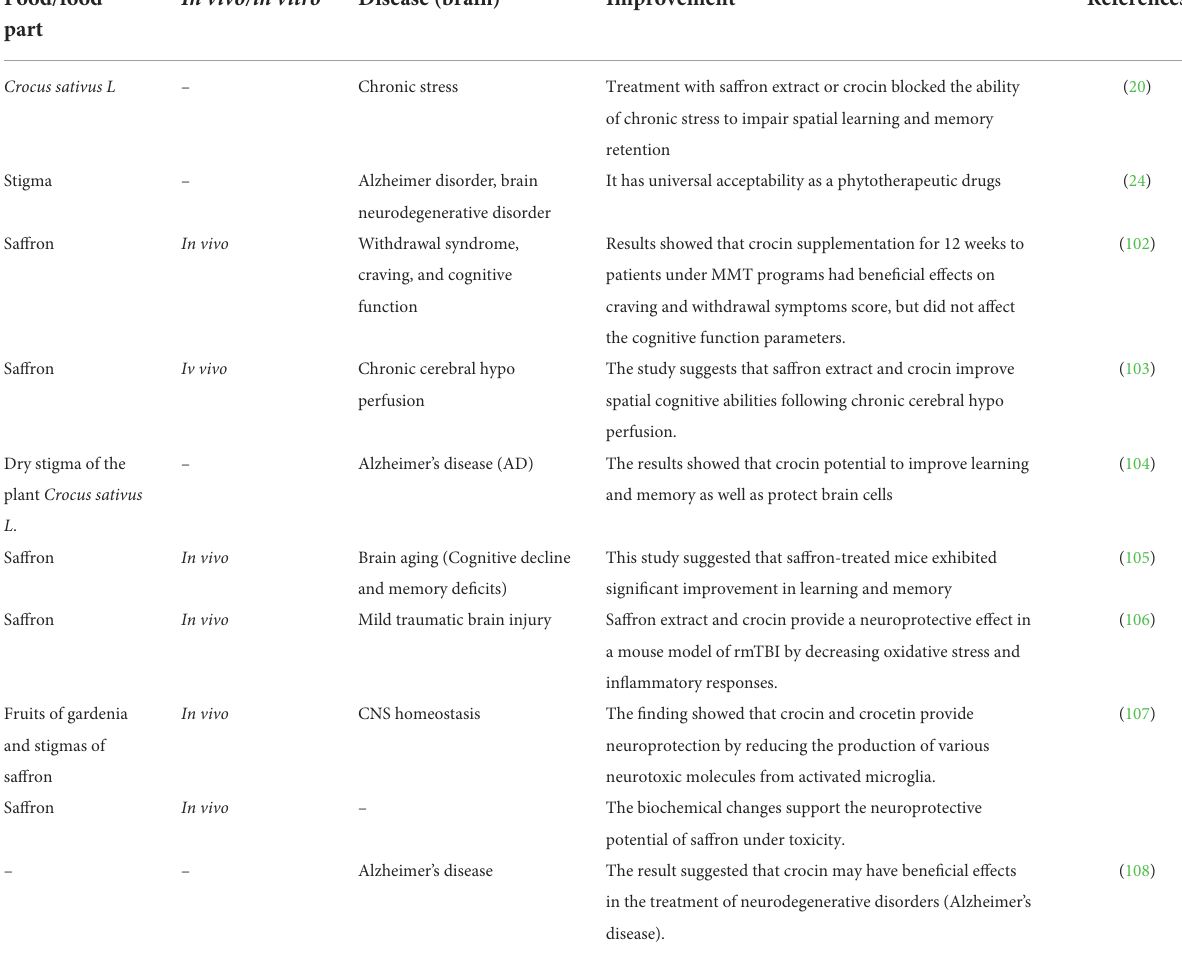
TABLE 3 Pharmacological potential of crocin in brain-related